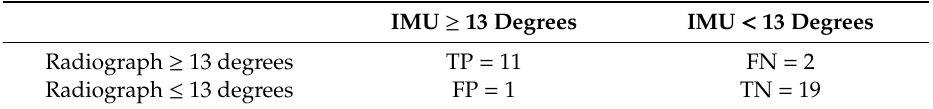
Table 1. Contingency table of results based on a threshold of ≥ 13 degrees classifying a patient as having high pelvic mobility when moving from standing to flexed-seated position. Values are counts of participants. Key: True positive (TP), false positive (FP), true negative (TN), false negative